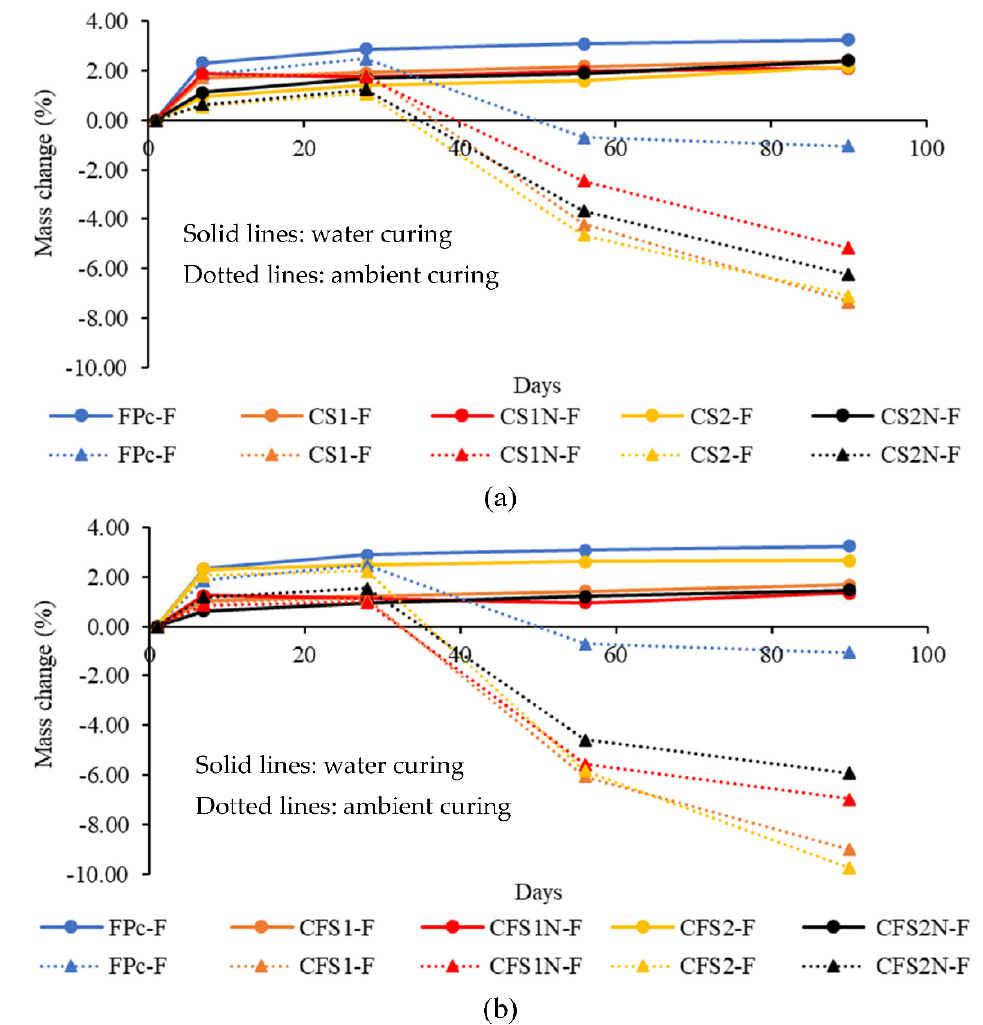
Figure 13. ( a ) Influence of the binary combinations of SCMs in reinforced binders on mass change. ( b ) Influence of the ternary combinations of SCMs in reinforced binders on mass change.